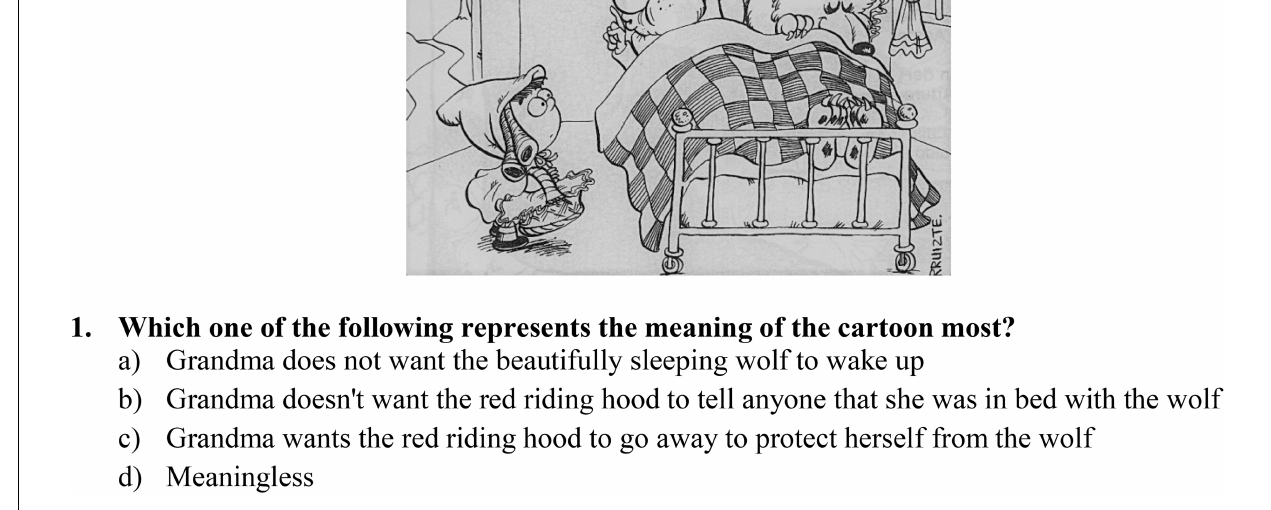
correct answer was scored as 1 point. The total